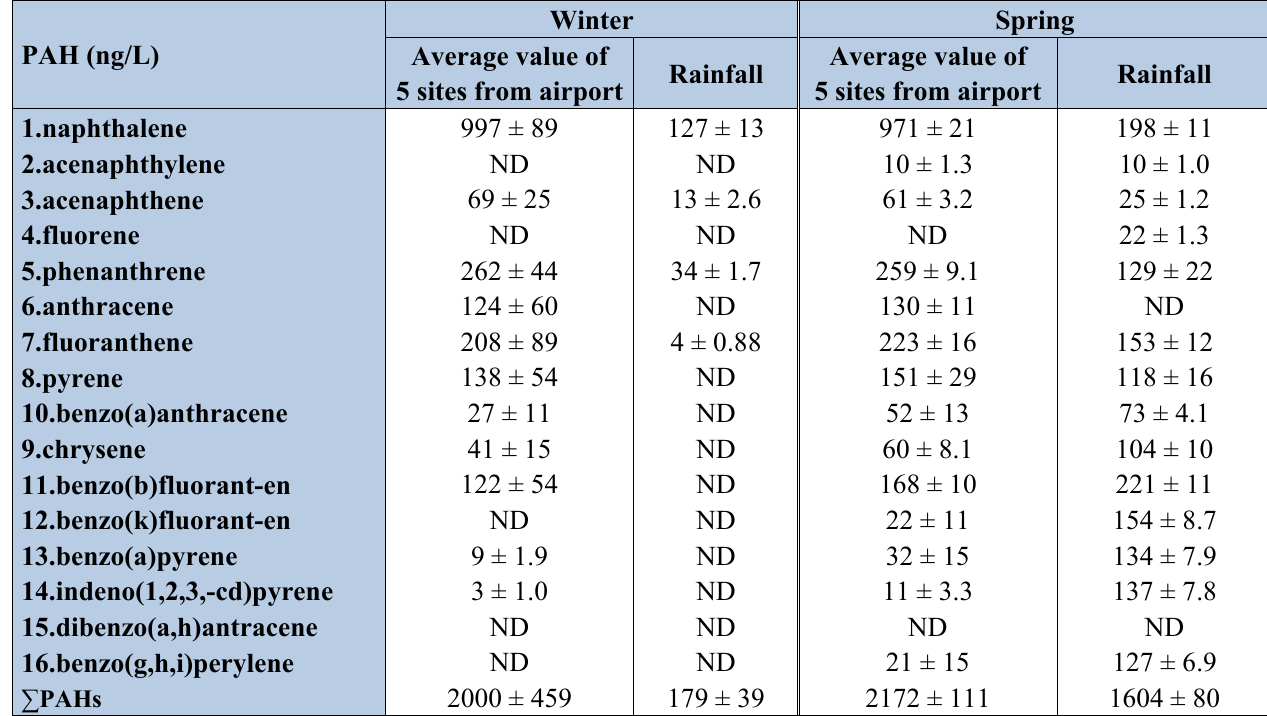
Table 8. The average PAH concentration determined in the runoff and rainfall water samples. PAH